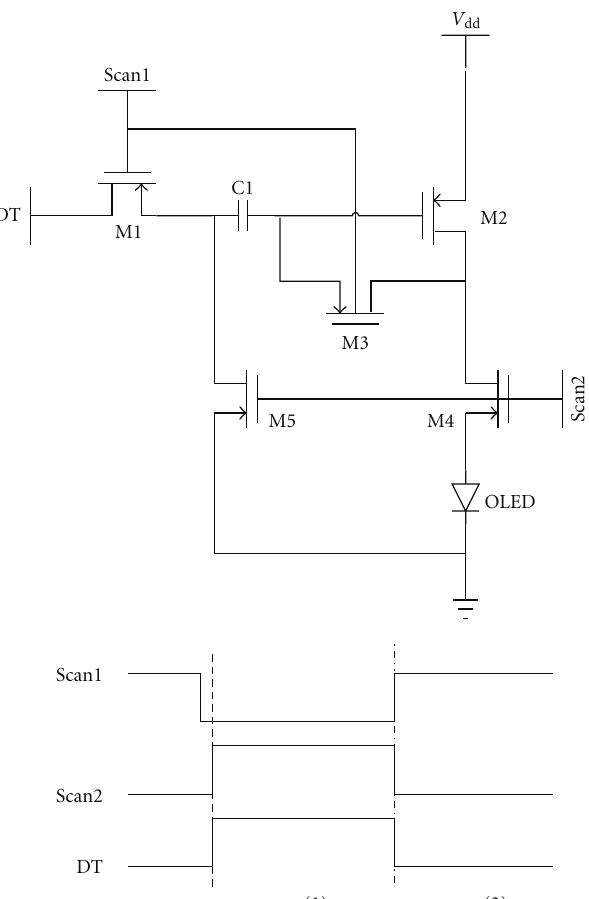
Figure 1: Signal lines for the proposed pixel circuit design and timing